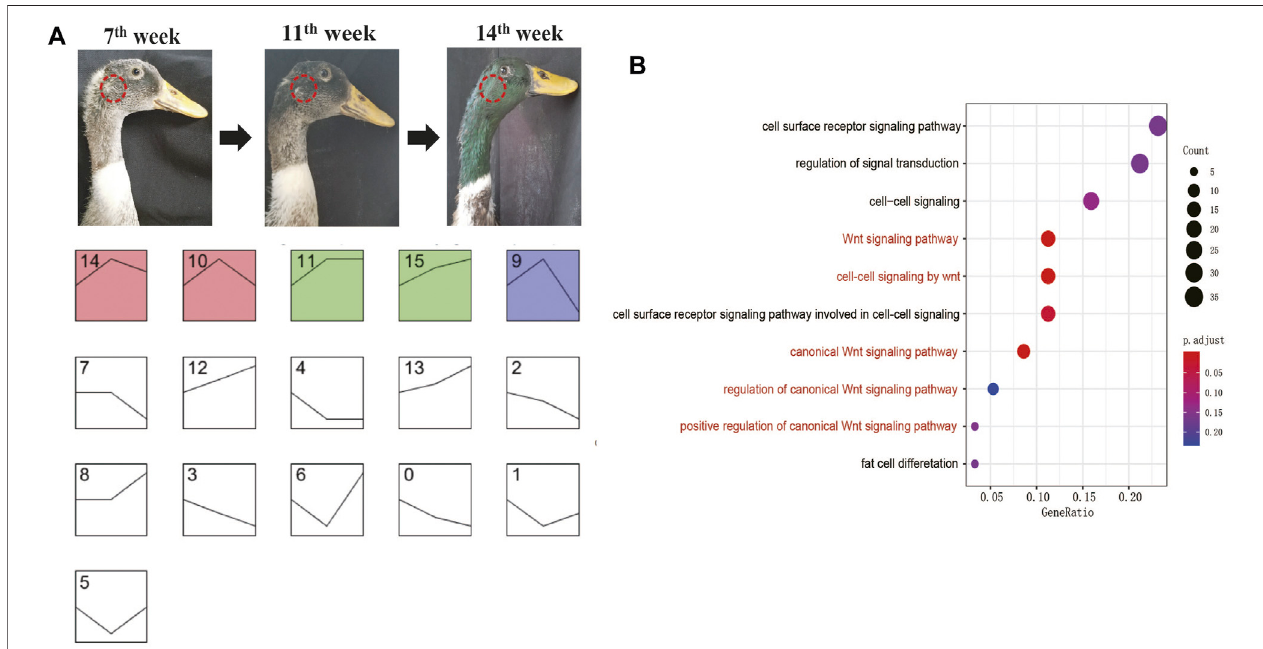
FIGURE 2 | Genome-wide gene expression trend analysis. (A) Classi fi cation of genome-wide gene expression trends in three growth stages. The sampling positionismarkedonthemallard.Eachsimpli fi edlinechartshowsatrendofgeneexpression.The Y -axiscoordinatesofthelinegrapharetheFPKMvalue,andthe X -axis coordinates are the growth stages (The three nodal points in the line graph represent 7th, 11th, and 14th weeks from left to right). (B) GO analysis of the genes in category 10.